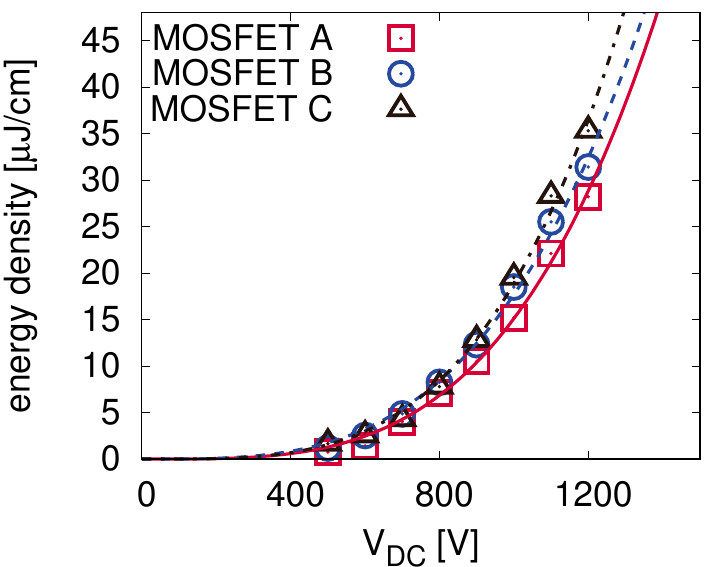
Figure 4. Pulse energy density as a function of the voltage of DC power supply for different SiC- MOSFETs. Fitting curves are also